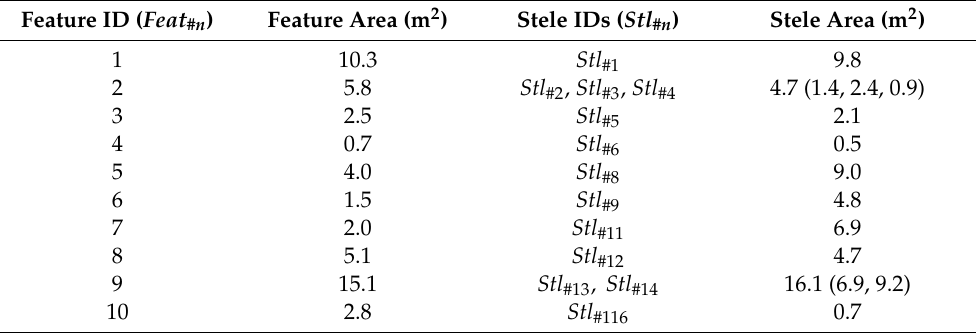
Table 4. Area of airborne hyperspectral imagery-derived water-bottom features compared those of steles from archaeological reference data. Coe ffi cient of determination R 2 = 0.72.